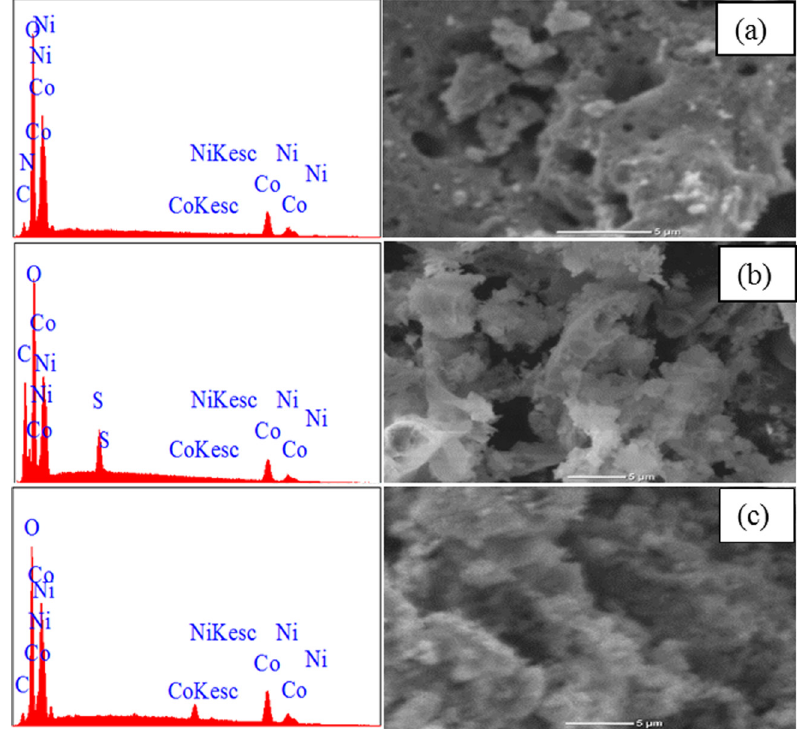
Fig. 2. SEM and EDS for NiCo 2 O 4 blank (a), ESM template (b), PMMA template